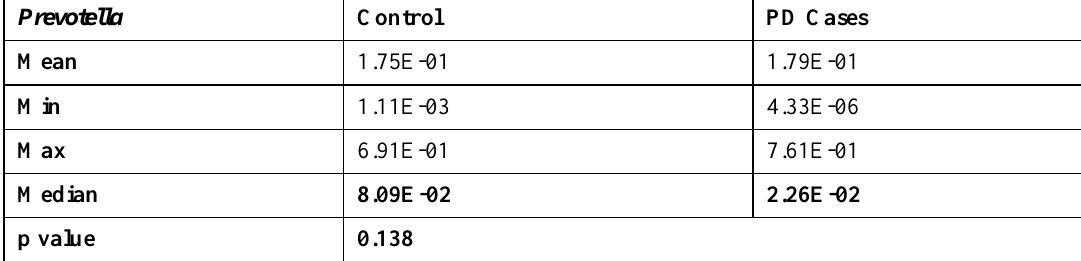
Table 4. Prevotella in PD and control